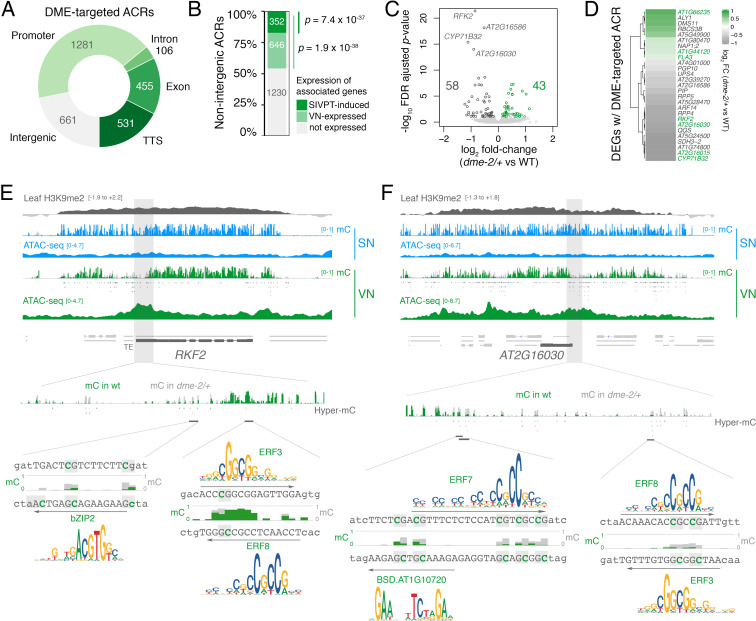
DEMETER (DME) activity regulates the expression of pollen tube-related genes.(A) Distribution of genomic features associated with DME-targeted accessible chromatin regions (ACRs). (B) Expression status of genes lying in the vicinity (<900 bp) of a DME-targeted ACR. Genes were classified as being expressed in the VN (TPM >1, light green) or by being upregulated during semi in vivo pollen tube (SIVPT) growth (dark green) (Leydon et al., 2017). Statistical enrichment of the overlap was determined using pairwise two-sided Fisher’s exact tests. (C) Volcano plot of differentially expressed genes (DEGs) in dme-2/+ pollen compared to wild type (WT). Upregulated genes are shown in green while downregulated genes are shown in dark grey. DEGs were defined as having an FDR-adjusted p-value <0.1. The top four most significantly downregulated genes are labelled. (D) Heatmap illustrating the magnitude of expression changes for DME-dependent DEGs directly associated with a DME-targeted ACR. Plotted is the log2 fold-change in dme-2/+ pollen compared to WT. VN-specific genes are highlighted in green. (E and F) Browser view of two VN-specific direct DME target genes – RECEPTOR-LIKE SERINE/THREONINE KINASE (RFK2) (E) and the AT2G16030 locus encoding a SAM-dependent methyltransferase (F). Both genes are marked with H3K9me2 in the sporophyte (log2 ChIP-seq enrichment relative to H3). Tracks illustrate ATAC-seq signals and the proportion of methylated cytosines in all contexts (mC) in SN (blue) and VN (green), with DNA methylation levels in dme-2/+ overlaid in grey. DME-dependent hyper-methylated cytosines (HMCs) are marked below. Shading indicates the flanking promoter region shown in the close-up view. Sequences surrounding predicted TF binding sites are shown, with the level of cytosine methylation at HMCs highlighted in green and grey for WT and dme-2/+, respectively. Arrows indicate the orientation and position of TF motifs with a corresponding position frequency matrix logo plotted above.